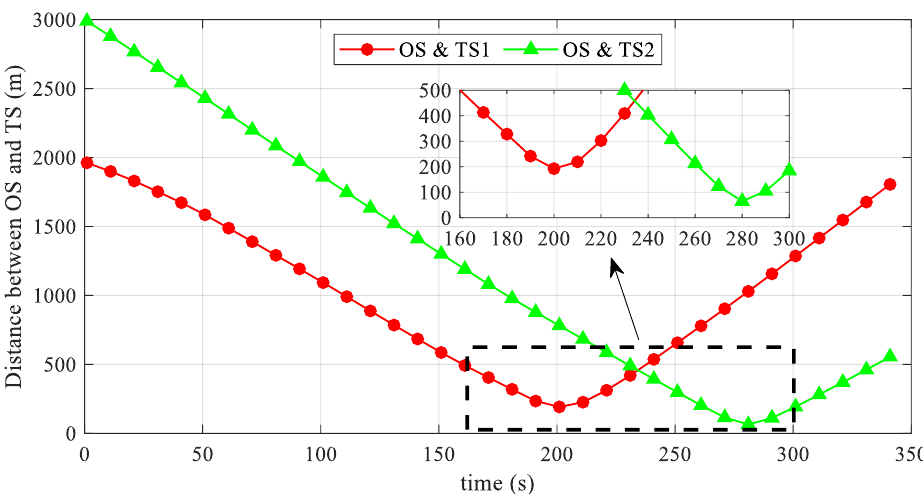
Figure 12. The relative distances between OS and TSs in the complex scenario.